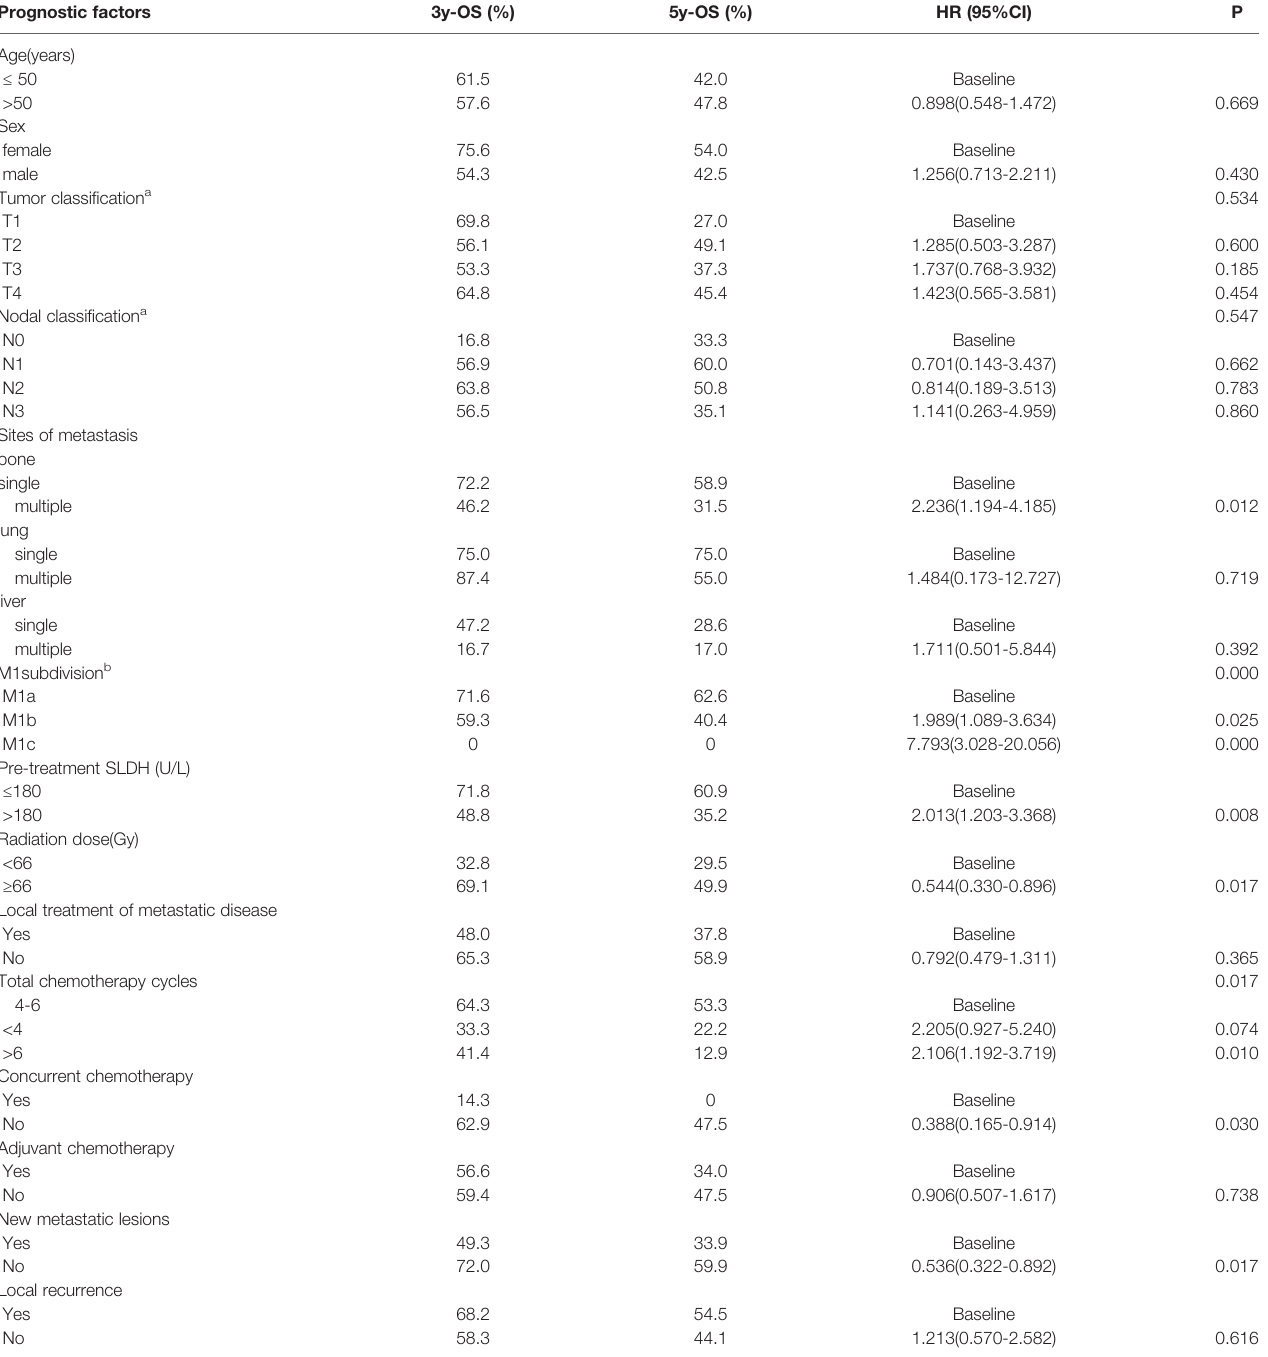
TABLE 5 | Univariate analysis of variables correlated with overall